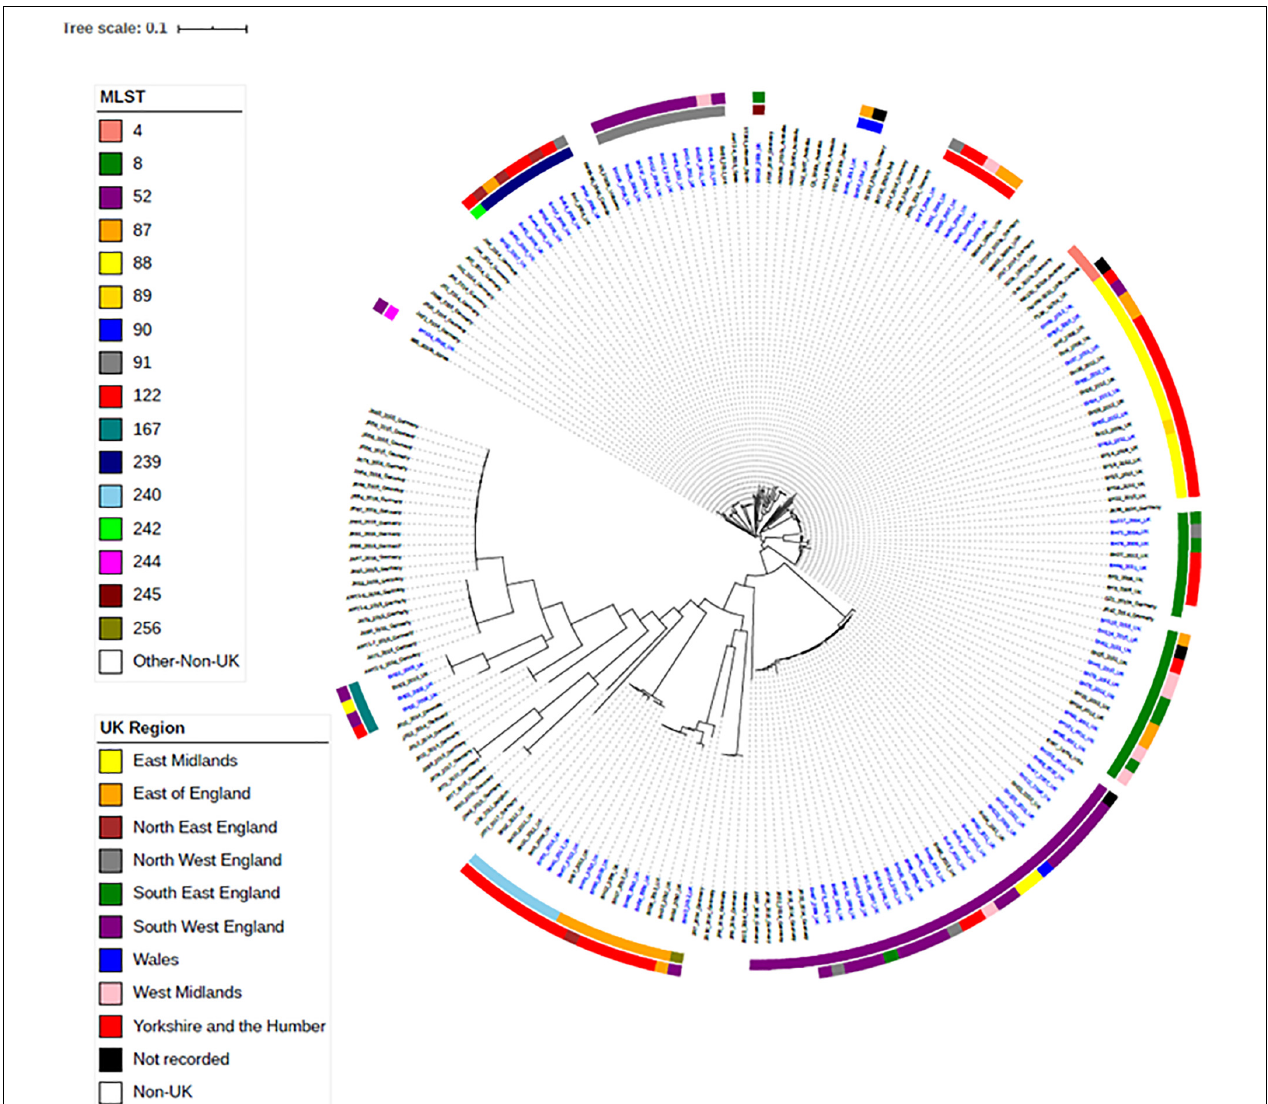
FIGURE 2 | Maximum-likelihood tree of B. hyodysenteriae isolates based on SNP in the core-genome. One hundred and fifteen UK isolates and eighty-two non-UK isolates published on NCBI have been included (Bellgard et al., 2009; Black et al., 2015; La et al., 2016b; Card et al., 2019). Isolates have their year and country of isolation shown next to their name. Isolates sequenced as part of this study are in blue font. The rings show the UK region and the ST of isolates. Branches are colored by bootstrap